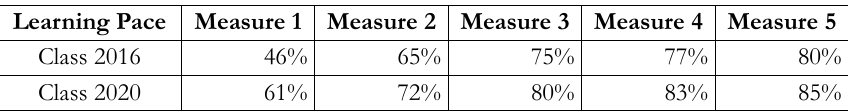
Table 8. Comparison of the learning pace periods 2016 and